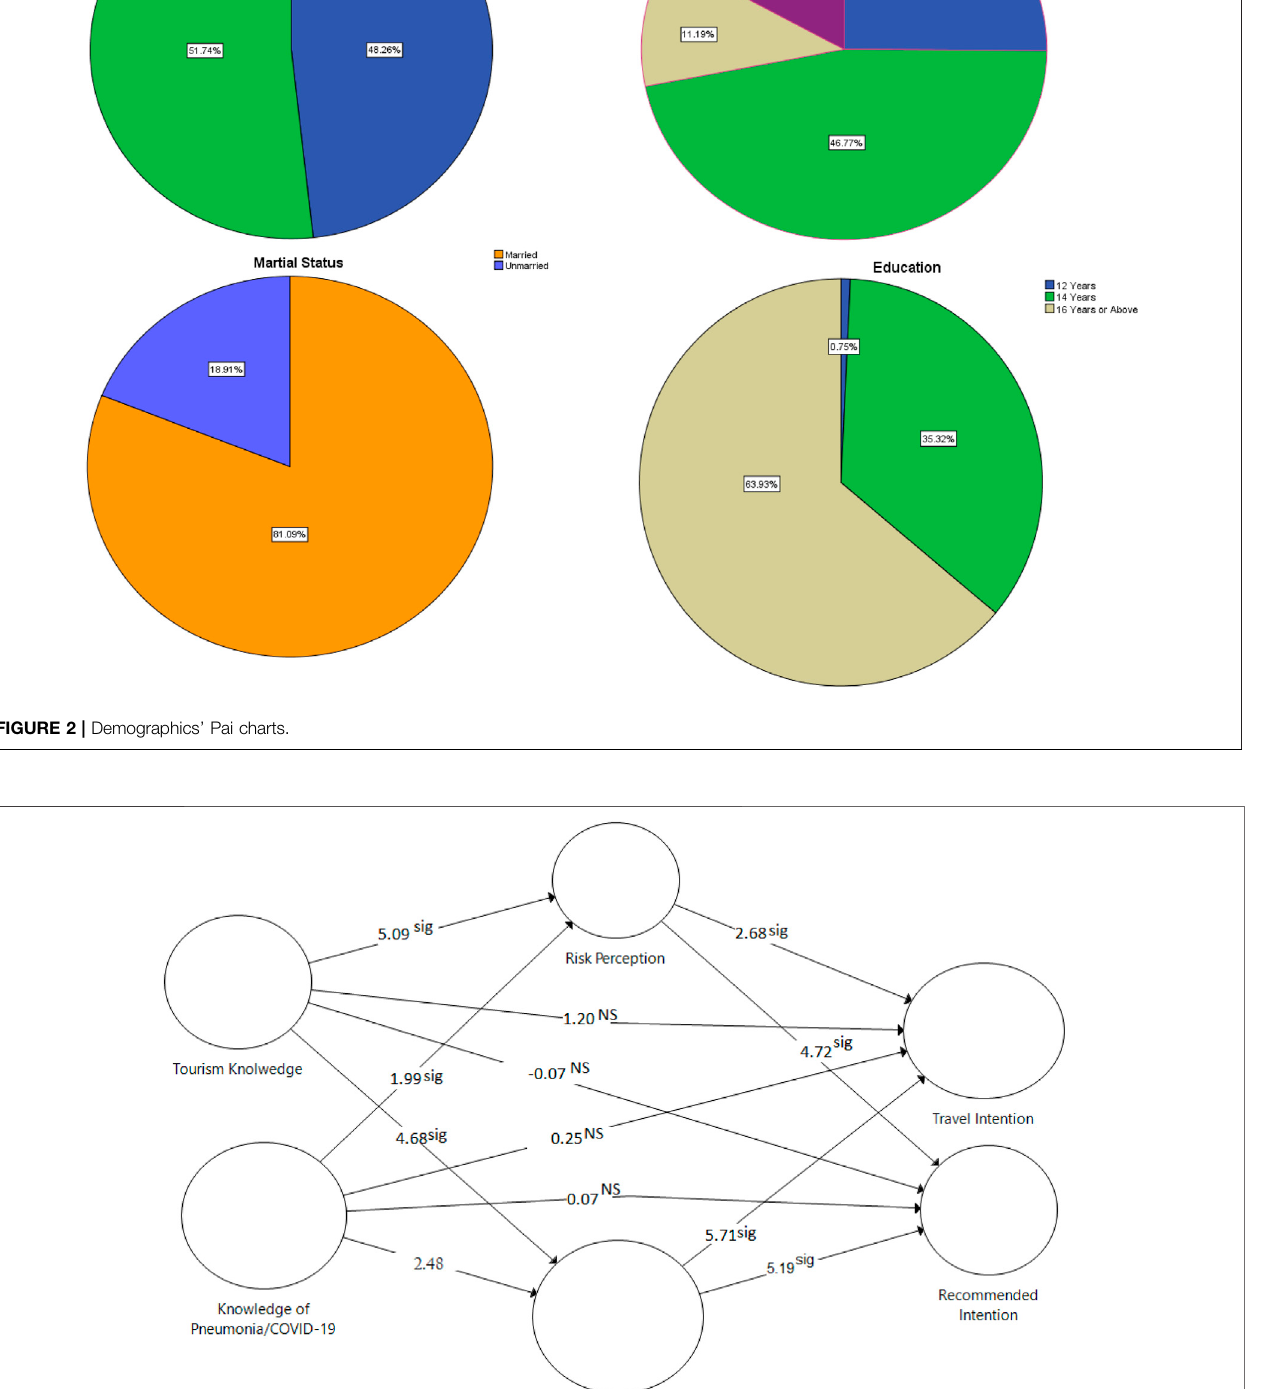
Frontiers in Environmental Science |